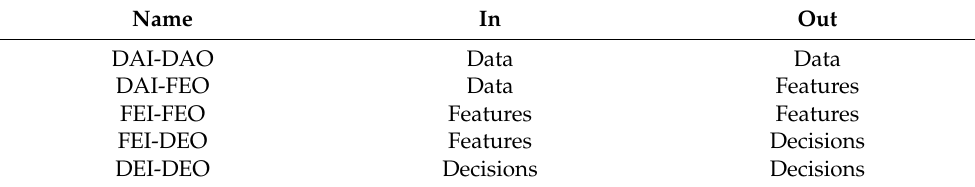
Table 1. Data fusion characterization based on input–output